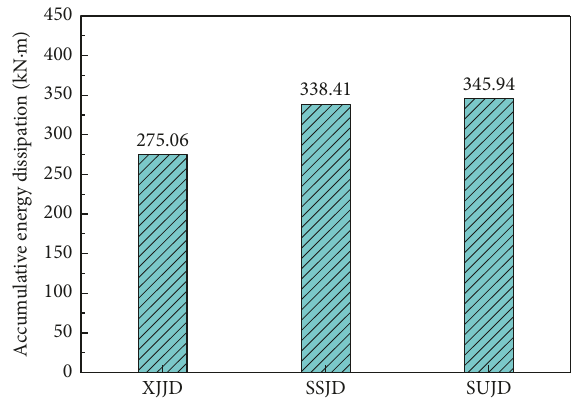
Figure 16: Accumulative energy dissipation of each specimen. Table 11: Average energy dissipation coefficient. Specimen no.